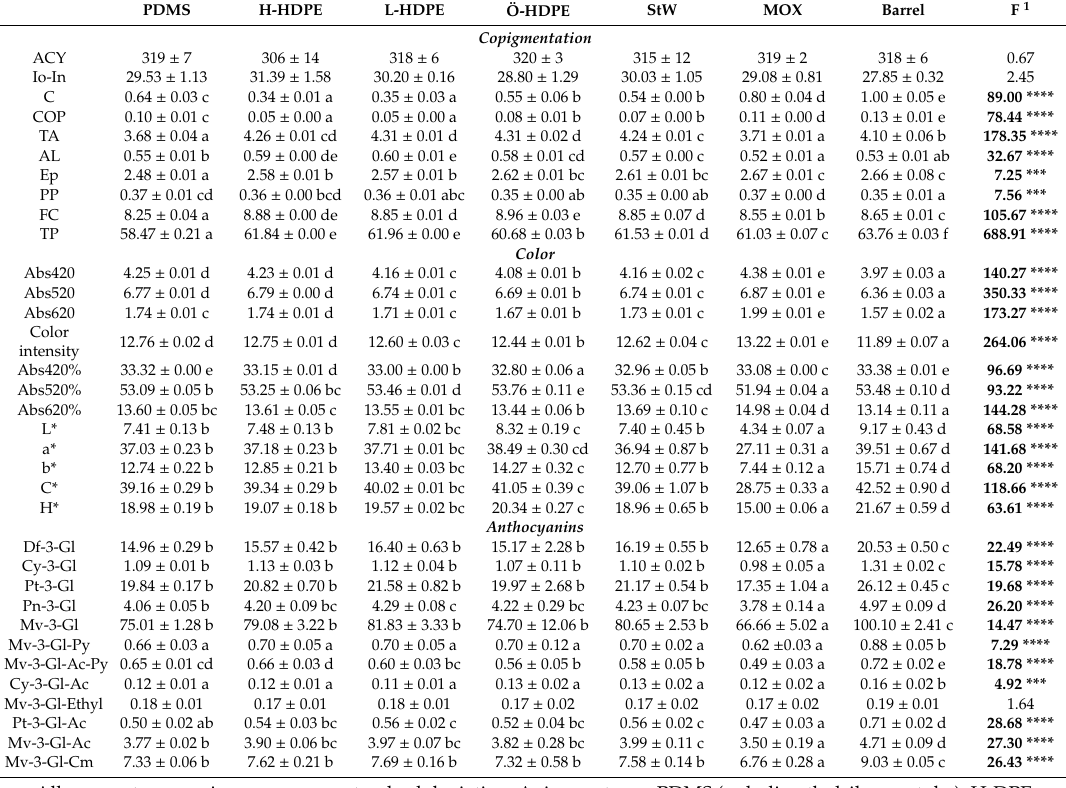
Table 2. Di ff erences among the wines aging in the di ff erent systems for 180 days.